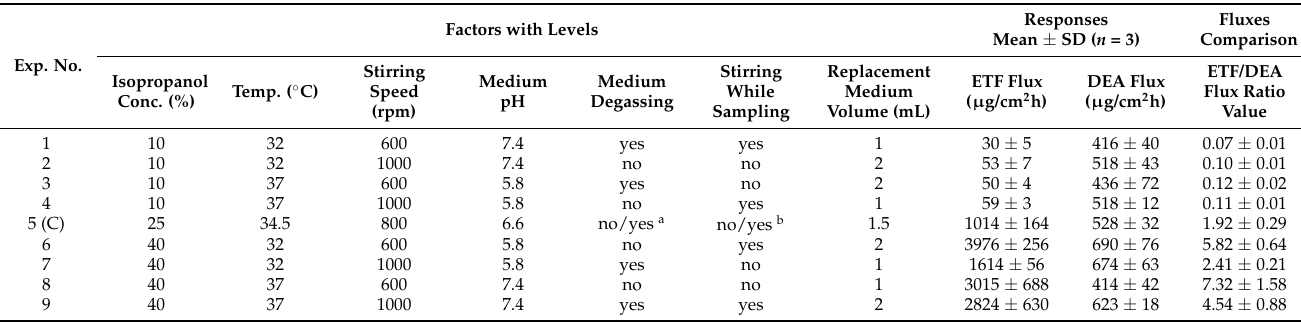
Table 2. Experimental plan of Plackett–Burman seven-factor eight-run screening design with a center point (C) and the observed response values (DEA and ETF fluxes and their ratio). Factors with Levels Responses Mean ± SD ( n = 3) Fluxes Comparison Exp. No. Isopropanol Conc.